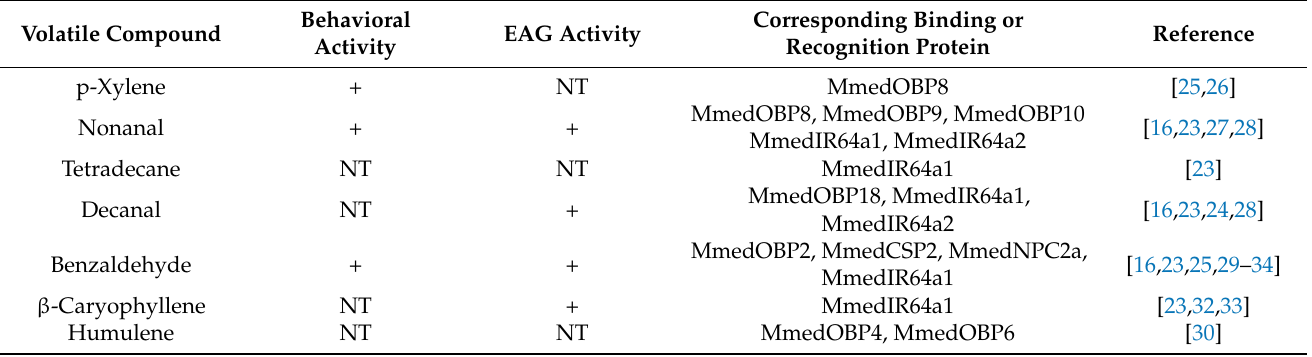
Table 2. Known effects of host-plant volatiles on the behavioral activity and EAG activity of Microplitis mediator and their corresponding binding or recognition protein. The “+” indicates a substance inducing behavioral attraction or electrophysiological (EAG) activity in the antennae of M. mediator